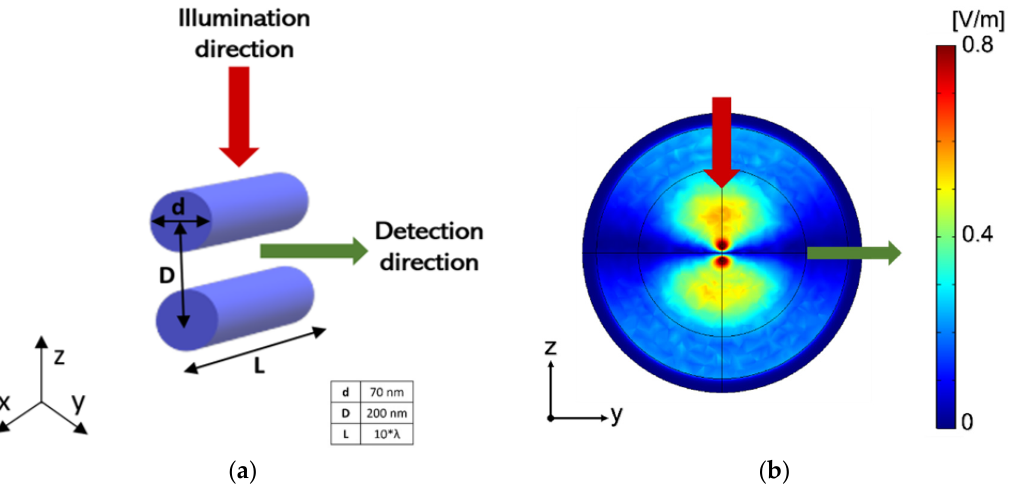
Figure 1. ( a ) Scheme of the proposed sensor based on two parallel silicon nanowires and its illumi- nation configuration. ( b ) Near-field map of the norm of the scattered field in the YZ plane. The gap distance is 200 nm. Illumination with a plane wave propagating along the negative direction of the z -axis and linearly polarized parallel to the axis of both nanocylinders ( x -axis).